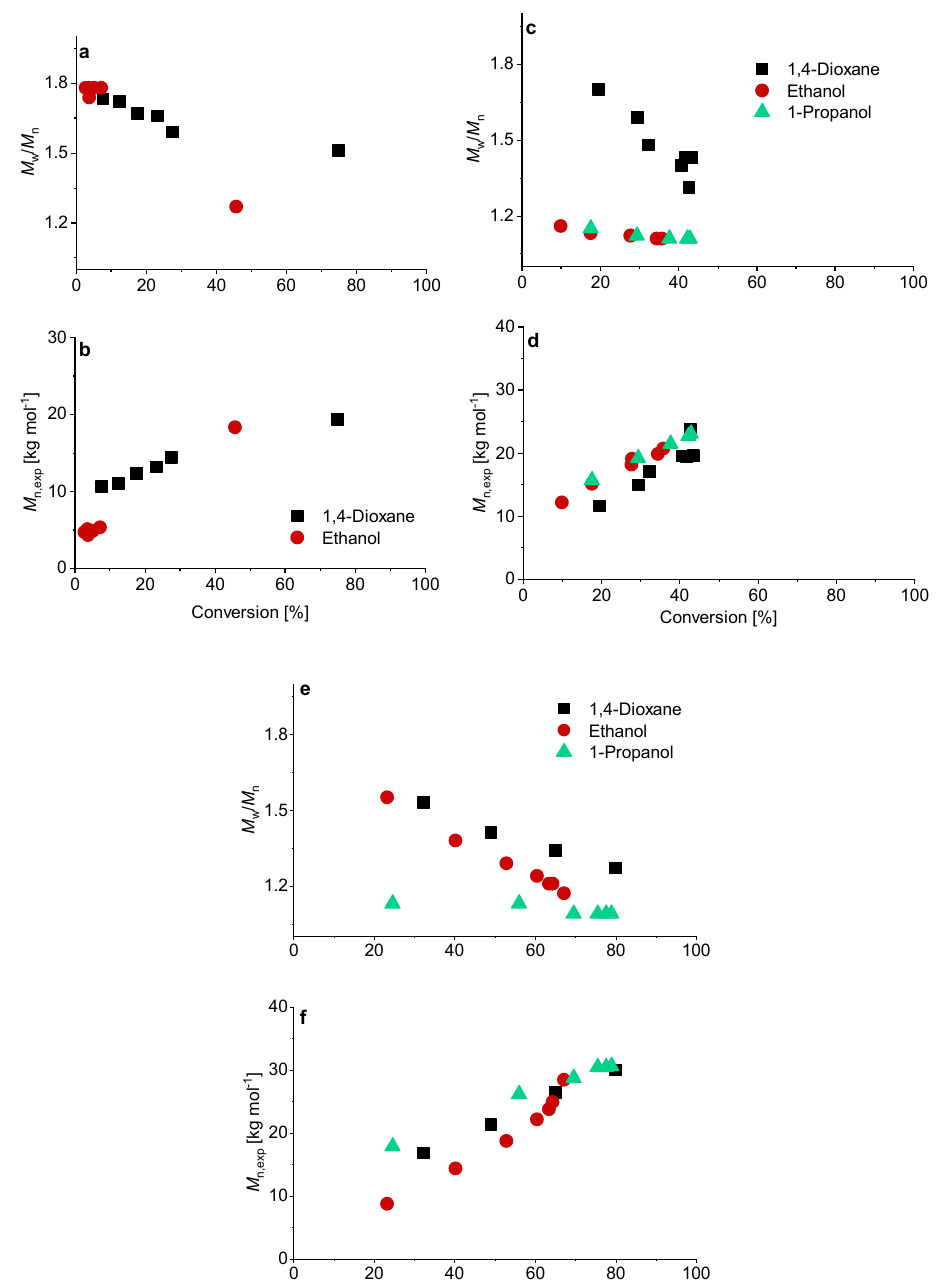
Figure 5. Conversion versus experimental number-average molar mass M n, exp and M w / M n of the RAFT polymerization of PMAA with CTA3 and a targeted DP of [MAA]/[CTA] = 120 and a molar ratio of [CTA]/[ACVA] = 10 at 70 °C ( a , b ). For the polymerizations at 80 °C a kinetical study with a molar ratio of [CTA]/[ACVA] = 10 ( c , d ) and 5 ( e , f ) is presented.